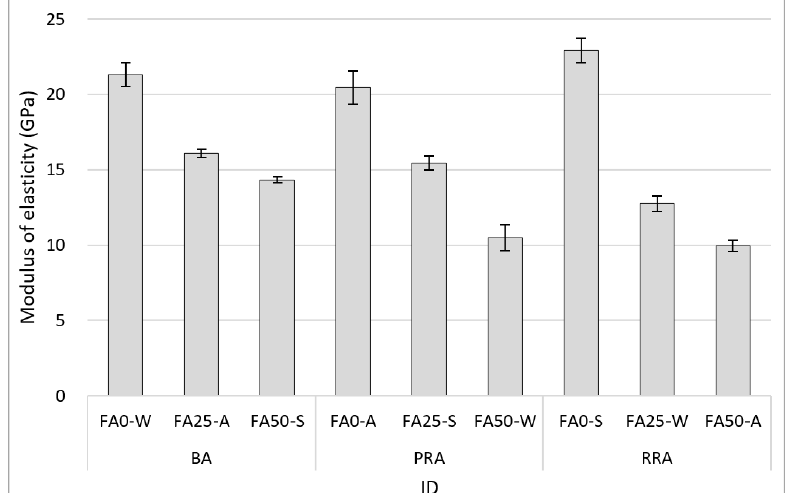
Figure 10. Modulus of elasticity of concrete.